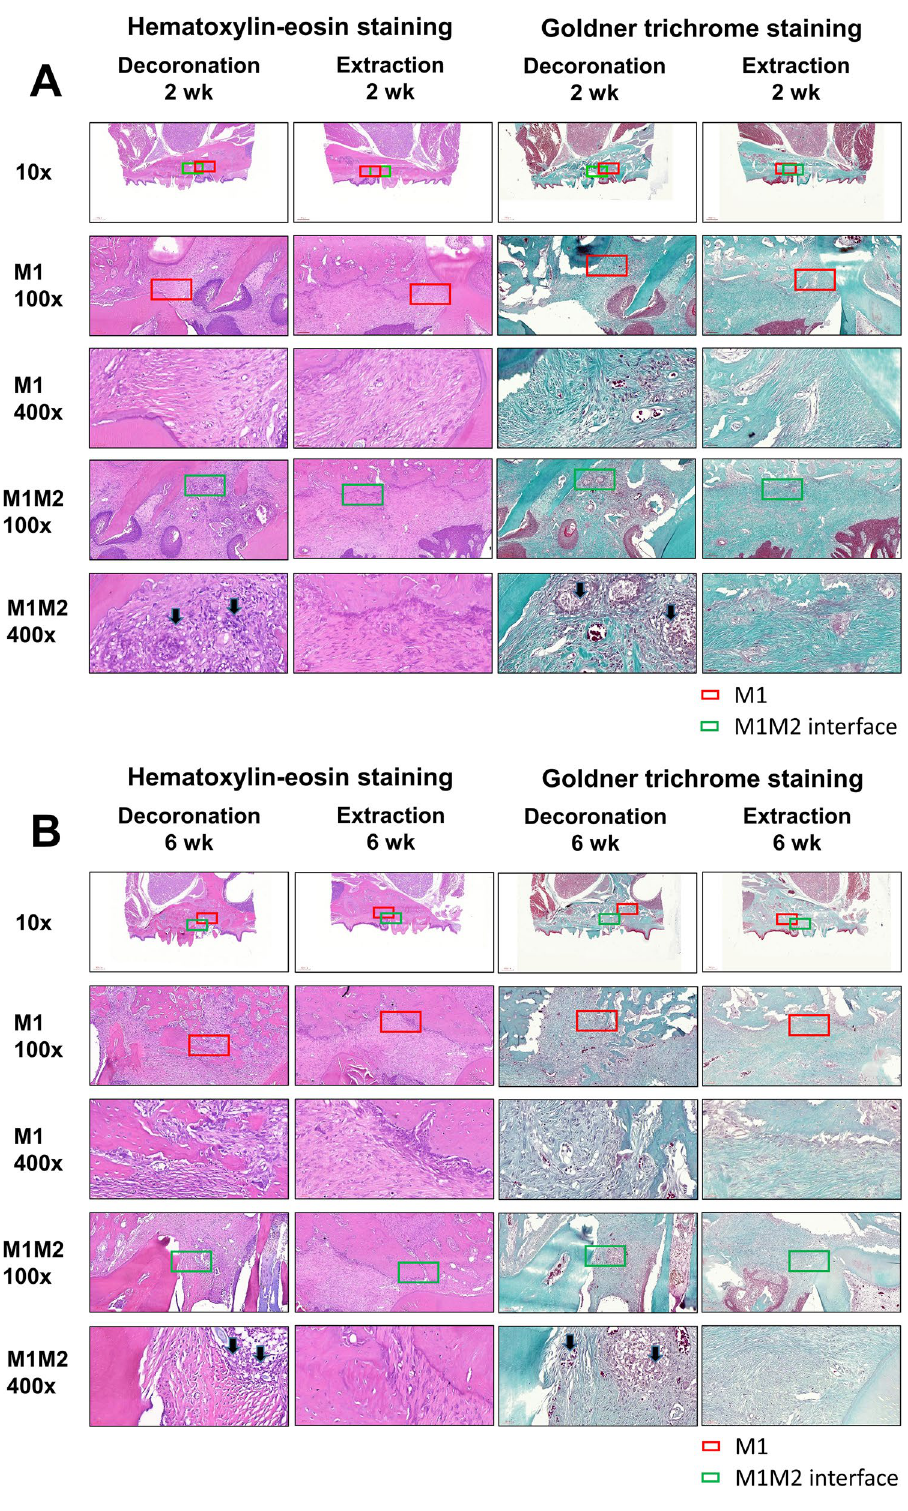
Figure 3. Representative histological sections of the maxillary first molar (M1) to third molar (M3) region of rats after after M1 decoronation or extraction; hematoxylin and eosin (H&E) or Goldner’s Trichrome staining. Sections were identified and photographed under 10x, 100x, and 400 × magnifications. Six weeks after M1 extraction, there were still some inflammatory cell infiltrations in the samples; however, these infiltrates decreased a lot at 10th and 14th weeks after extraction. The decoronation samples were dominated by inflammatory granulation tissues, blood vessels with different calibers, and inflammatory cell infiltrations at 6–14 weeks; moreover, intensive alveolar bone resorption activity was characterized by the presence of a border of osteoclasts (arrow) at the M1-M2 junction (green box). With Goldner’s Trichrome staining, the collagenous fiber, fibrin and erythrocytes were selectively visualized. The fibrous connective tissue with the presence of granulation tissue with excessive inflammatory cell infiltrations were clearly demonstrated in the decoronation